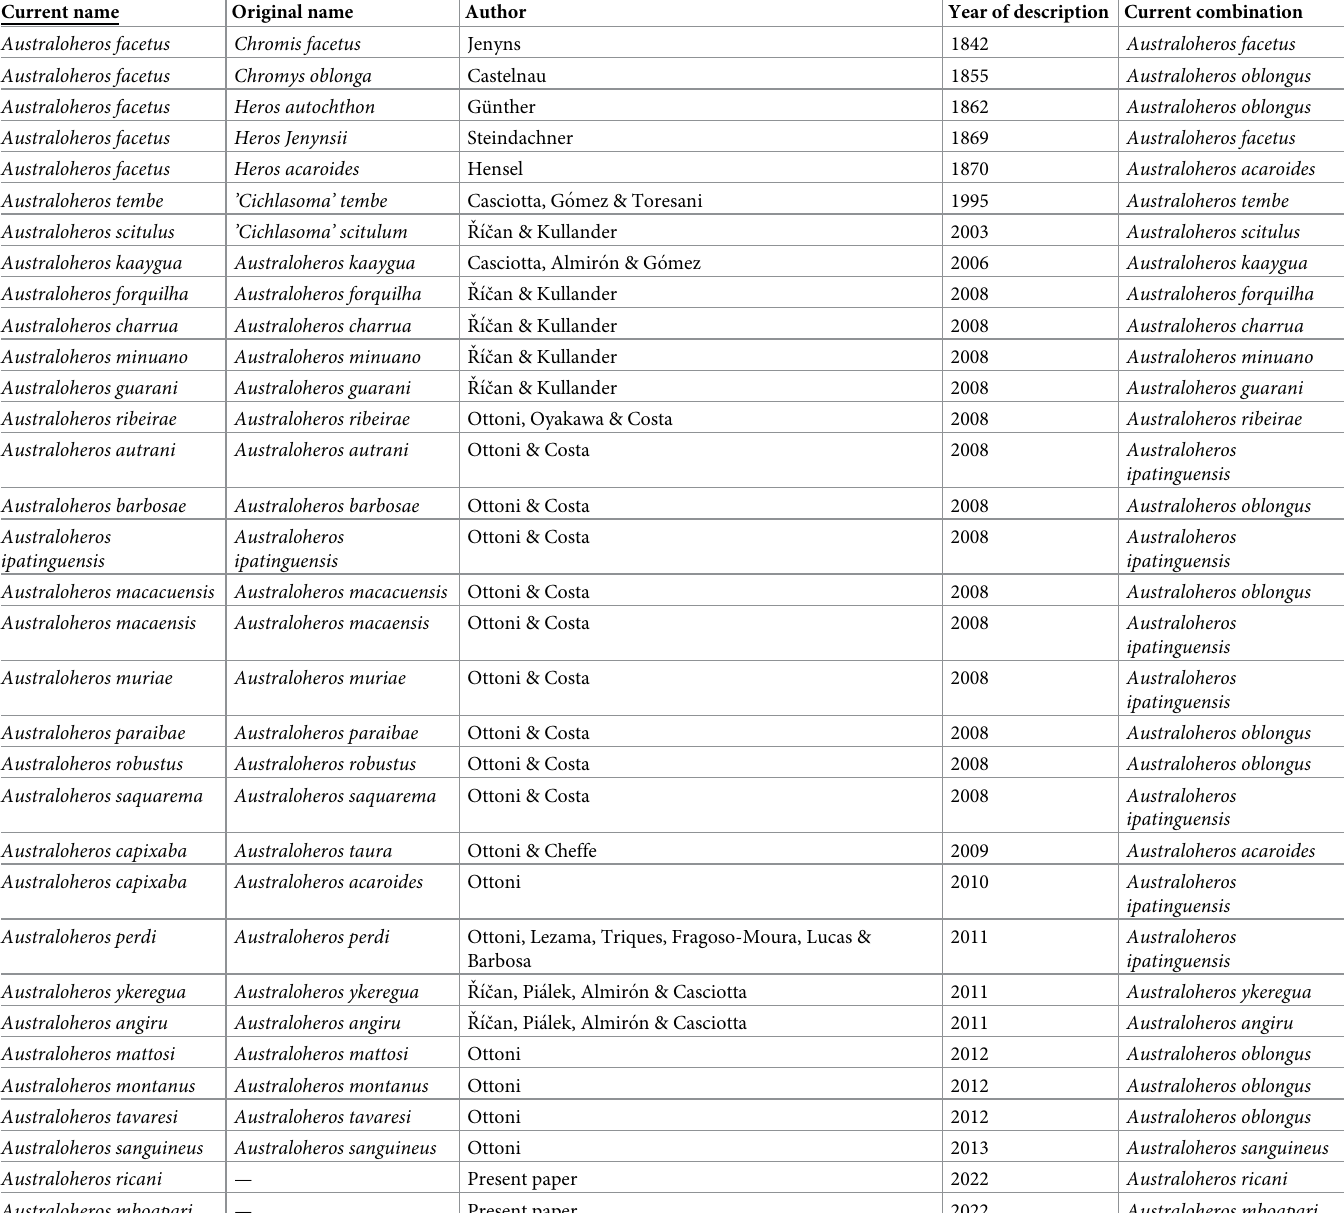
Table 2. Nominal species of Australoheros in order of description, and recommended